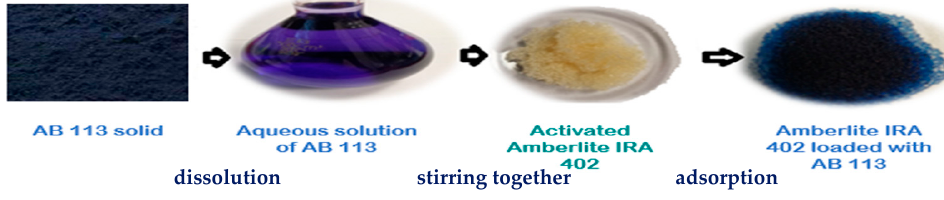
Figure 3. Image of batch adsorption process of AB 113 onto Amberlite IRA 402.